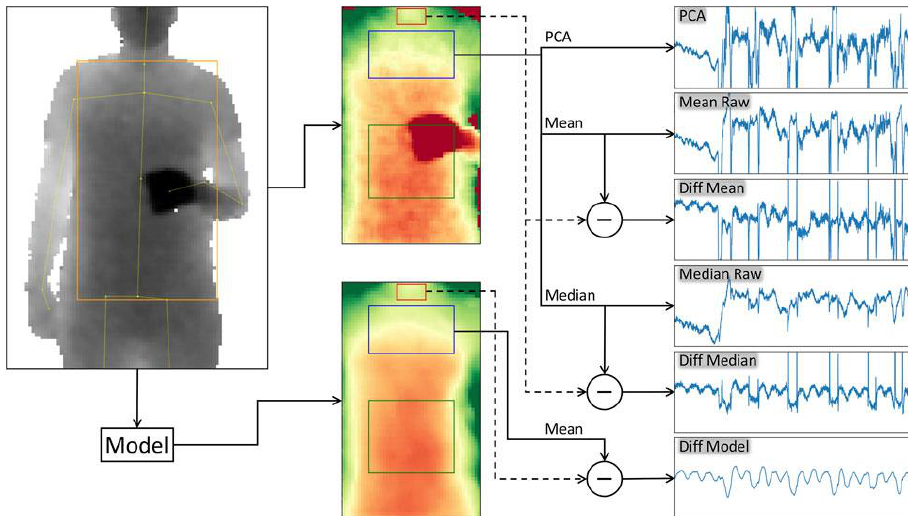
Figure 7. Comparison of six different methods for determining respiration rate. Principal component analysis (PCA) from the raw signal of the region of interest (ROI). Mean of ROI (Mean Raw), the median of ROI (Median Raw). Use of a reference plane to subtract motion about the mean (Diff Mean) and median (Diff Median). Application of an own model with the help of a reference plane (Diff Model). Figure taken from [41], licensed via Creative Commons Attribution License and not changed for this work.